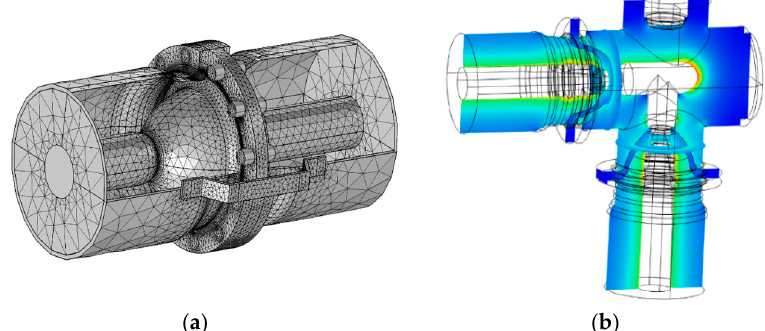
Figure 1. Three dimensional finite element models: ( a ) section of bus-spacer intersection; and ( b ) 90° elbow.